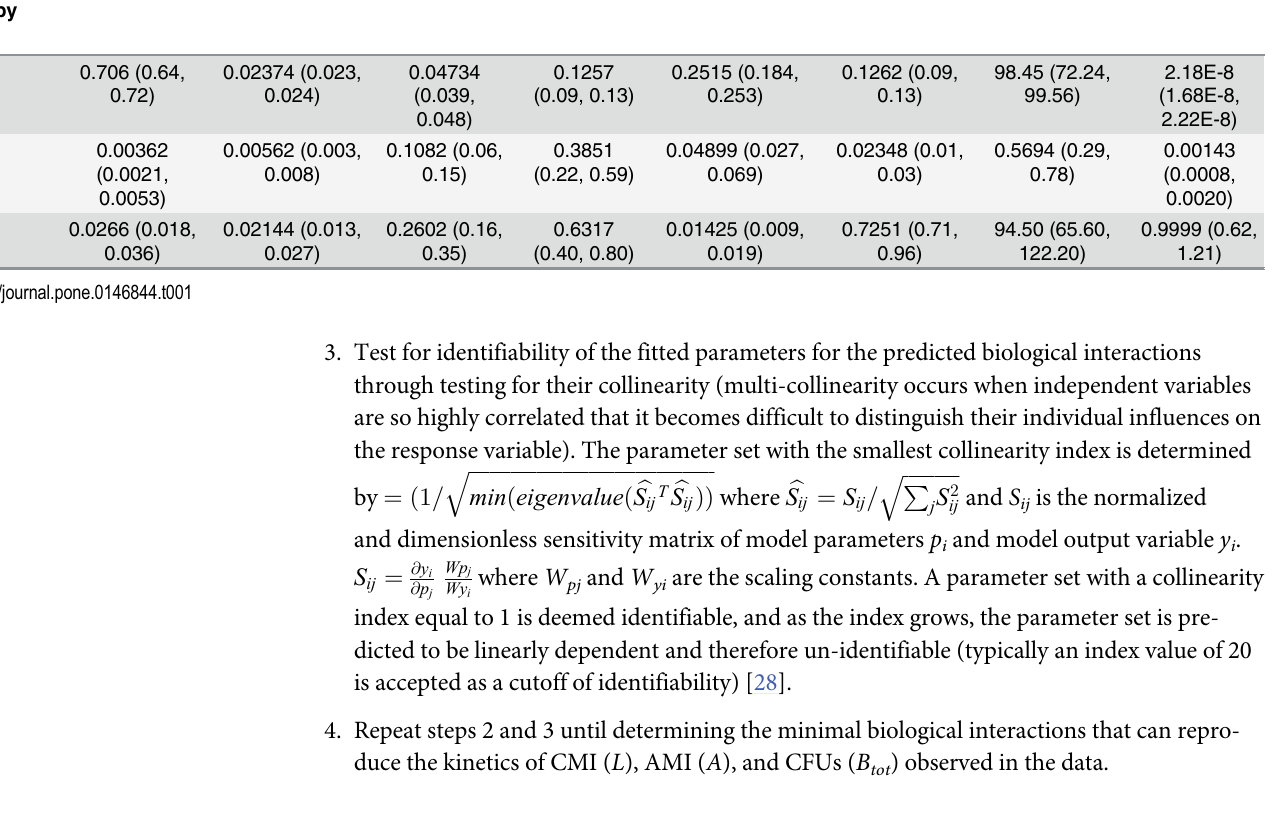
ffiffiffiffiffiffiffiffiffiffiffi P q b S ij ¼ S ij = S 2 where is the normalized and S ij ij j and model output variable y i i